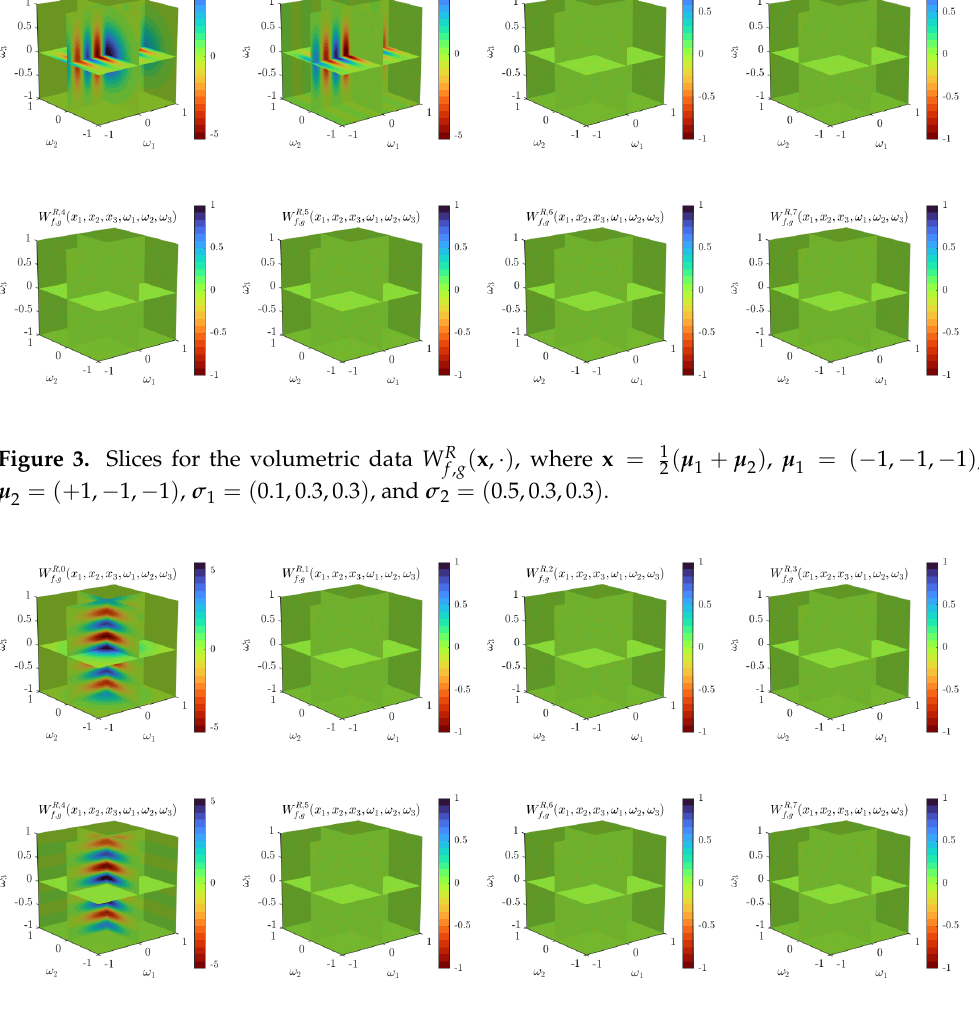
( x , · ) , where x = 1 f , g